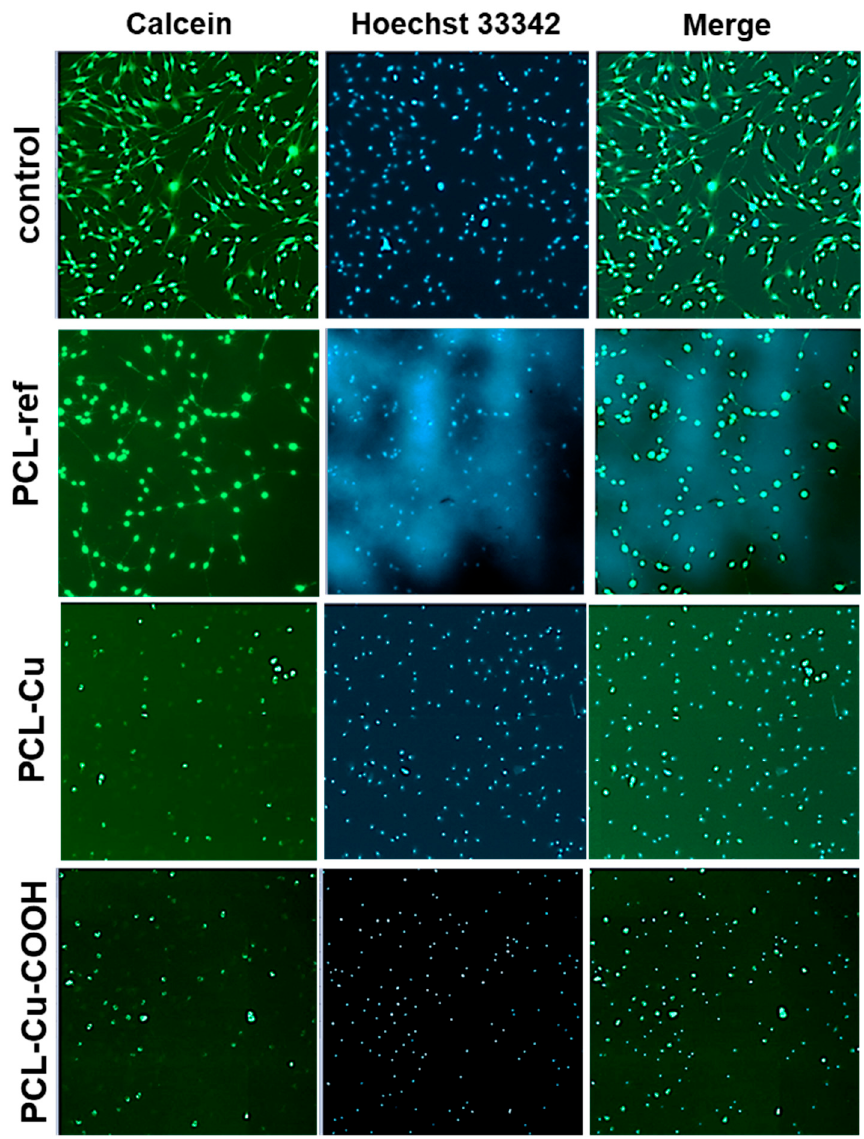
Figure 13. Mesenchymal stromal cells viability on the surface of PCL-ref, PLC-Cu, PCL-Cu-COOH, and on cultural plastic (control) after 3 days of cultivation. PCLs were preliminarily incubated in a culture medium for 1 h. Live cells were determined using calcein ‐ AM, which changes from a non ‐ fluorescent state to a fluorescent state (green) due to enzymatic conversion of intracellular esterases. The cell nuclei were stained by Hoechst 33342 (blue). Magnification 40x.